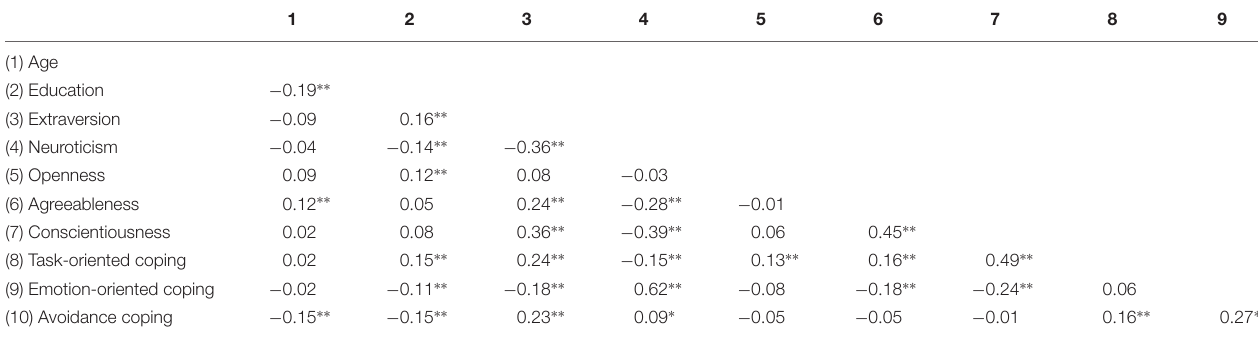
TABLE 2 | Correlations between personality traits and coping styles ( N = 465).